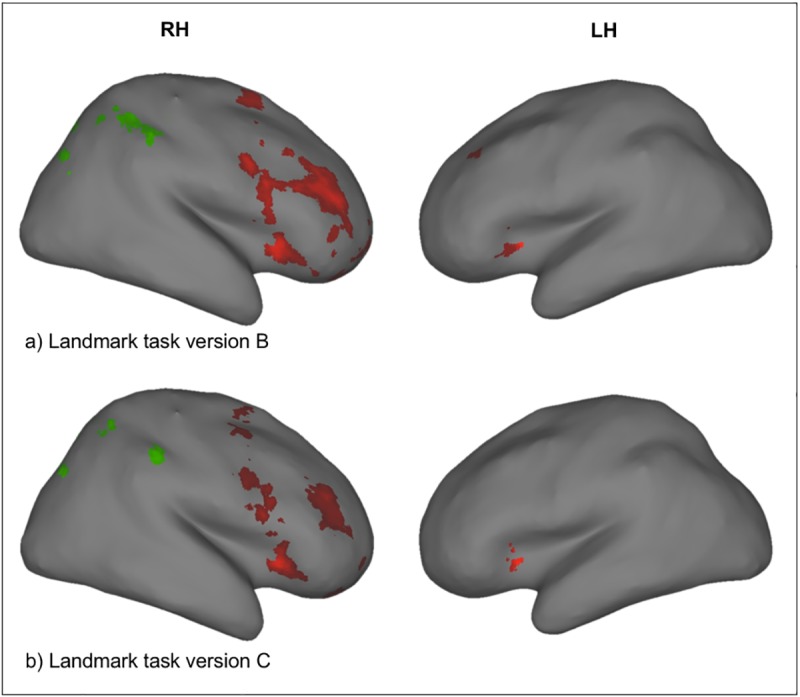
Landmark task ROIs.Frontal (red) and parietal (green) ROIs are shown for Landmark task version B (a) and C (b). Frontal and parietal ROIs were defined by creating a mask, resembling the conjunction of the group level activation patterns of session 1 and 2 within the frontal lobe and parietal lobe, respectively, as given by the WFU-Pickatlas (p < 0.01 uncorrected, k = 20). RH = right hemisphere, LH = left hemisphere.